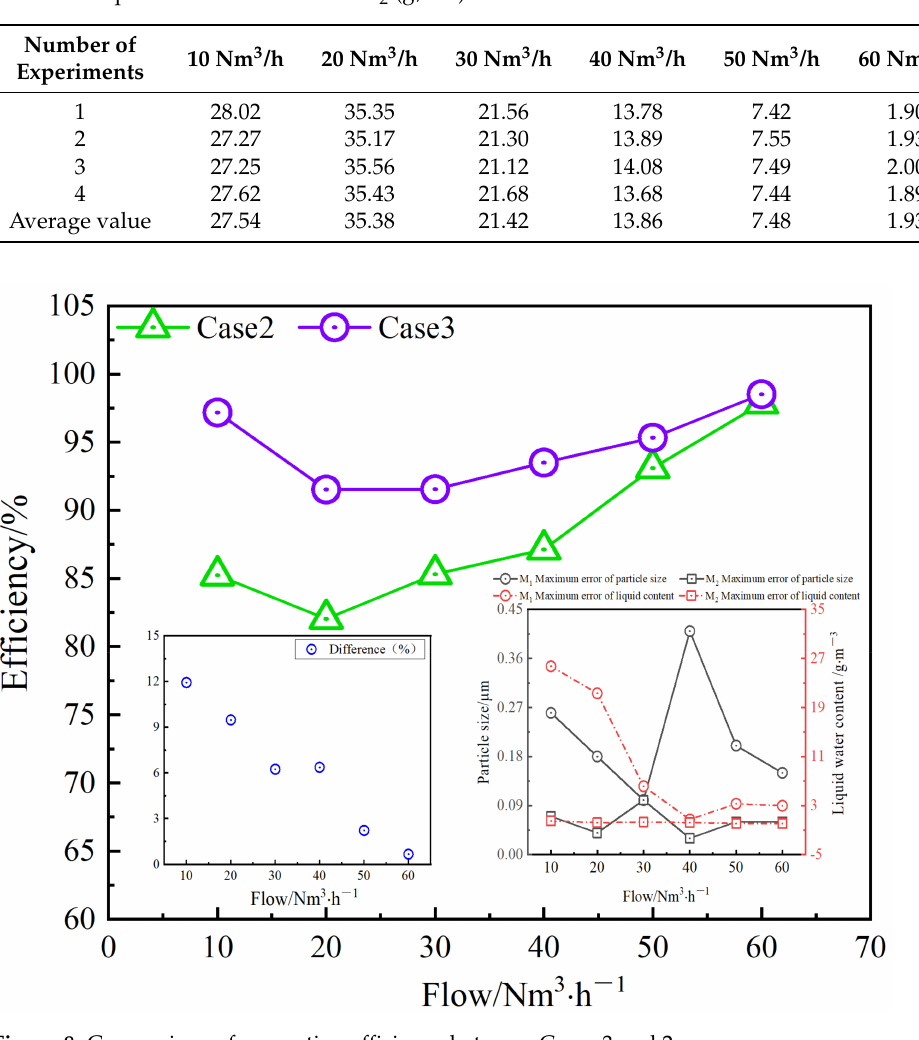
Figure 8. Comparison of separation efficiency between Cases 3 and